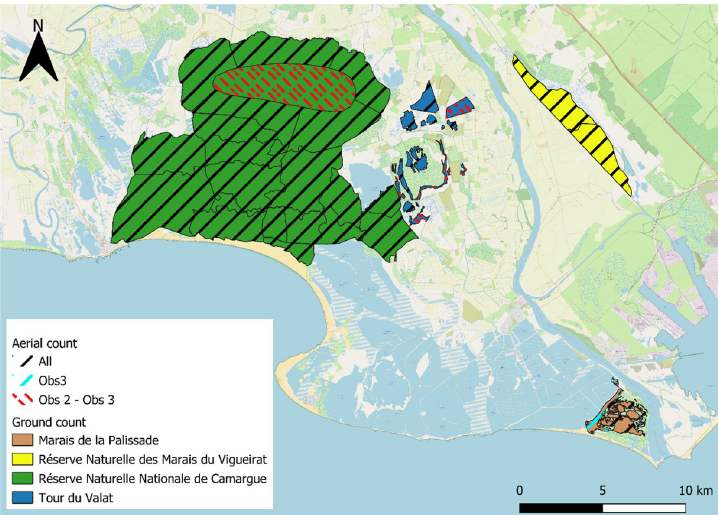
Fig 1. Location of the 40 sites in the study area. Ten sites were distributed within the Tour du Valat (in blue), 21 sites at the Re´serve Naturelle Nationale de Camargue (in green), two sites at the Re´serve Naturelle des Marais du Vigueirat (in yellow) and seven sites at the Marais de la Palissade (in brown). For aerial counts, 32 sites were counted by the first observer (1975–2002), 39 sites by the second (2004–2013) and 40 sites by the last (2014–2020). Ground data were collected by different observers and the year in which monitoring began differed among sites. Background map is provided by © OpenStreetMap contributors available under the Open Database License (https://www.openstreetmap.